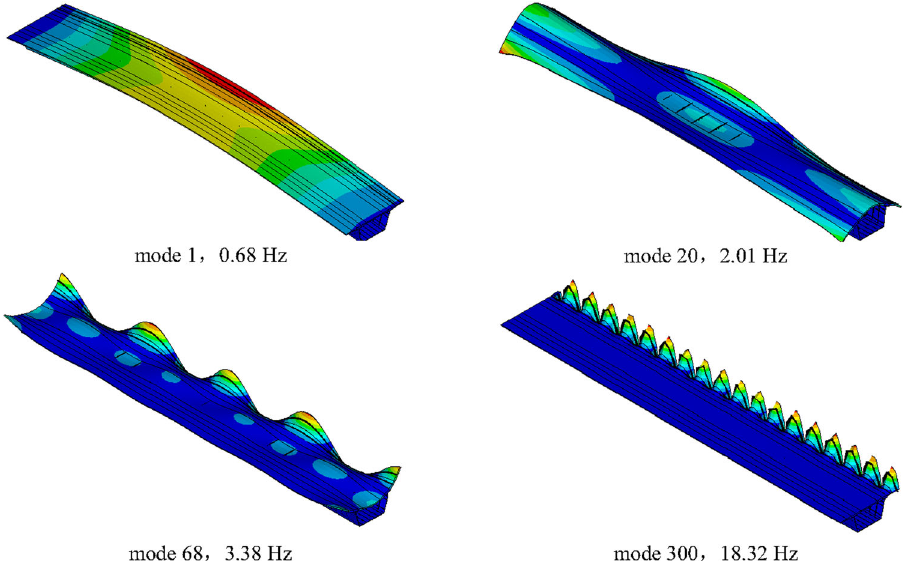
Fig. 5 Typical modal shapes and frequencies of substructure 4 of the composite box girder